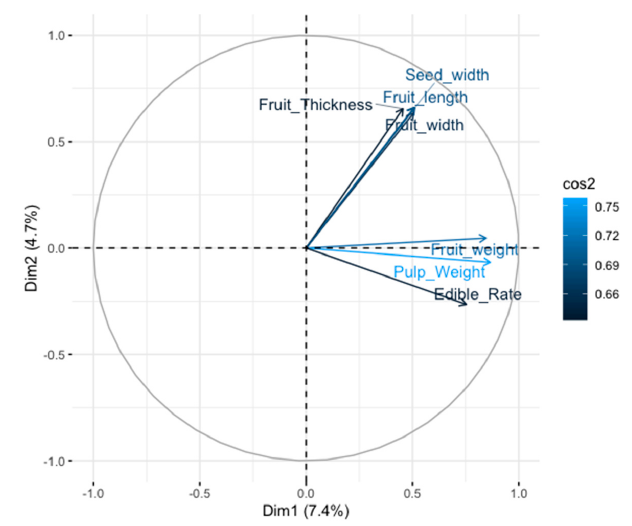
Figure 6. Correlation circle based on principal component analysis; only variables significantly represented on the principal components (cos 2 > 0.5) are displayed.